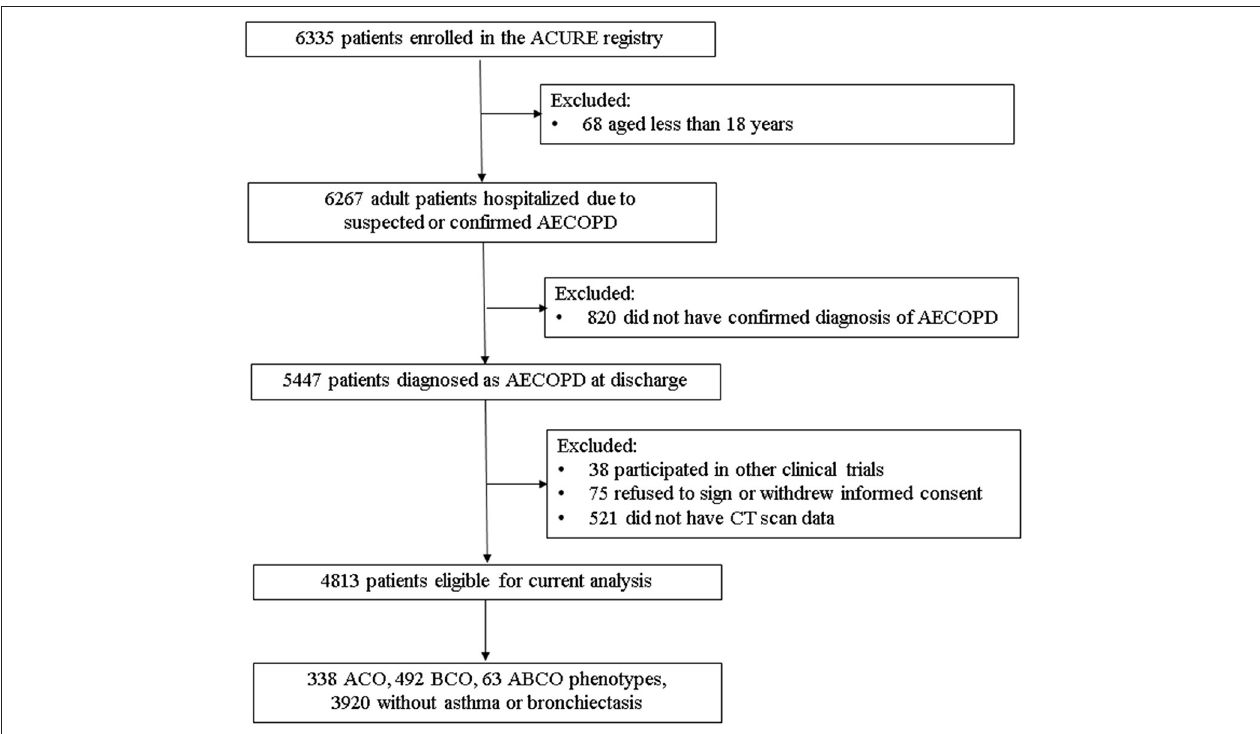
FIGURE 1 | Flowchart of diagram in current analyses. ABCO, chronic obstructive pulmonary disease patients comorbid with asthma and bronchiectasis; ACO, asthma-chronic obstructive pulmonary disease overlap; ACURE, the acute exacerbation of chronic obstructive pulmonary disease inpatient registry; AECOPD, acute exacerbation of chronic obstructive pulmonary disease; BCO, bronchiectasis- chronic obstructive pulmonary disease overlap; CT, computed tomography.